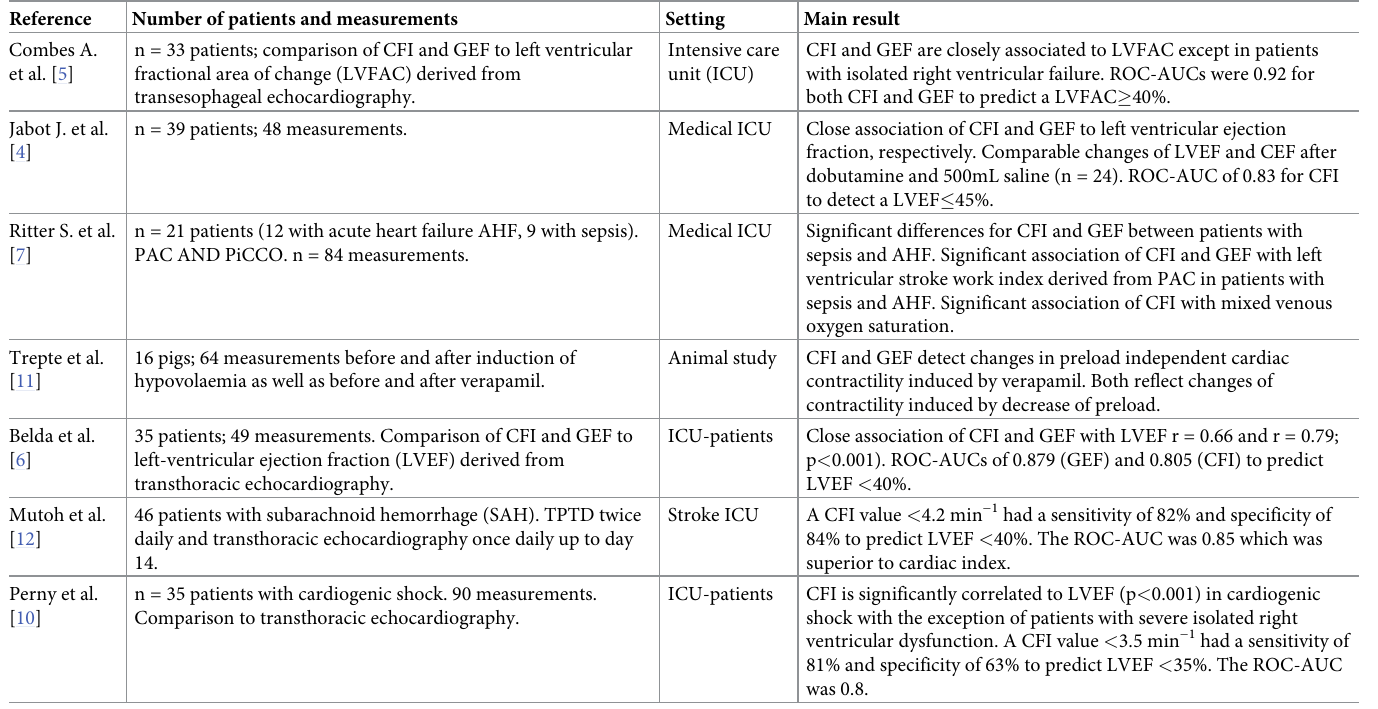
Table 2. Overview of studies on cardiac function index